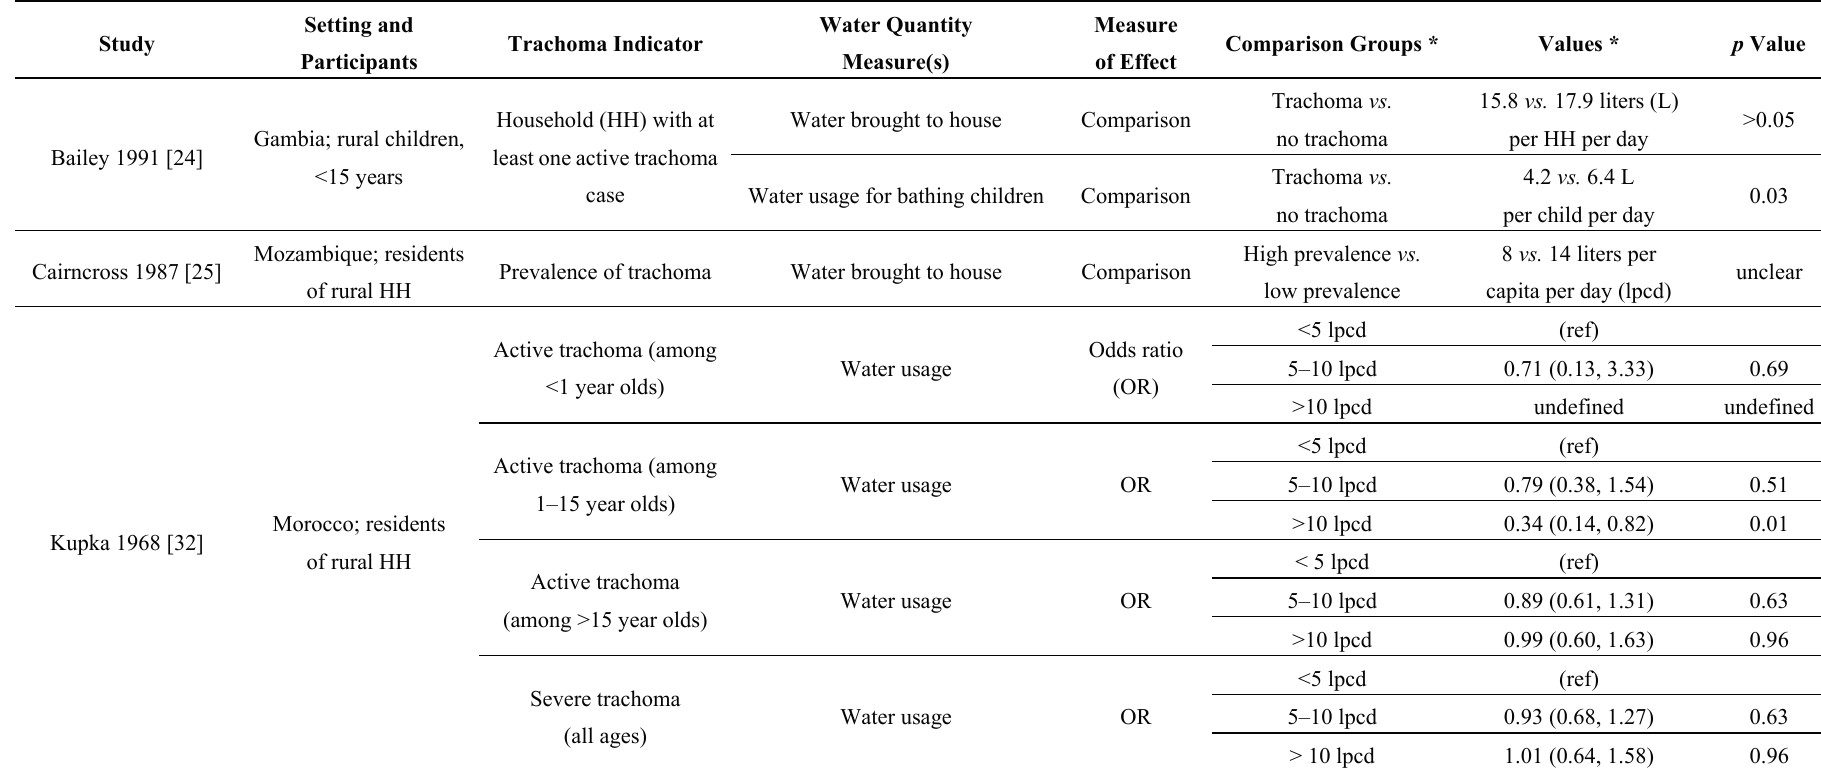
Table 2. Effects of Water Quantity on Trachoma